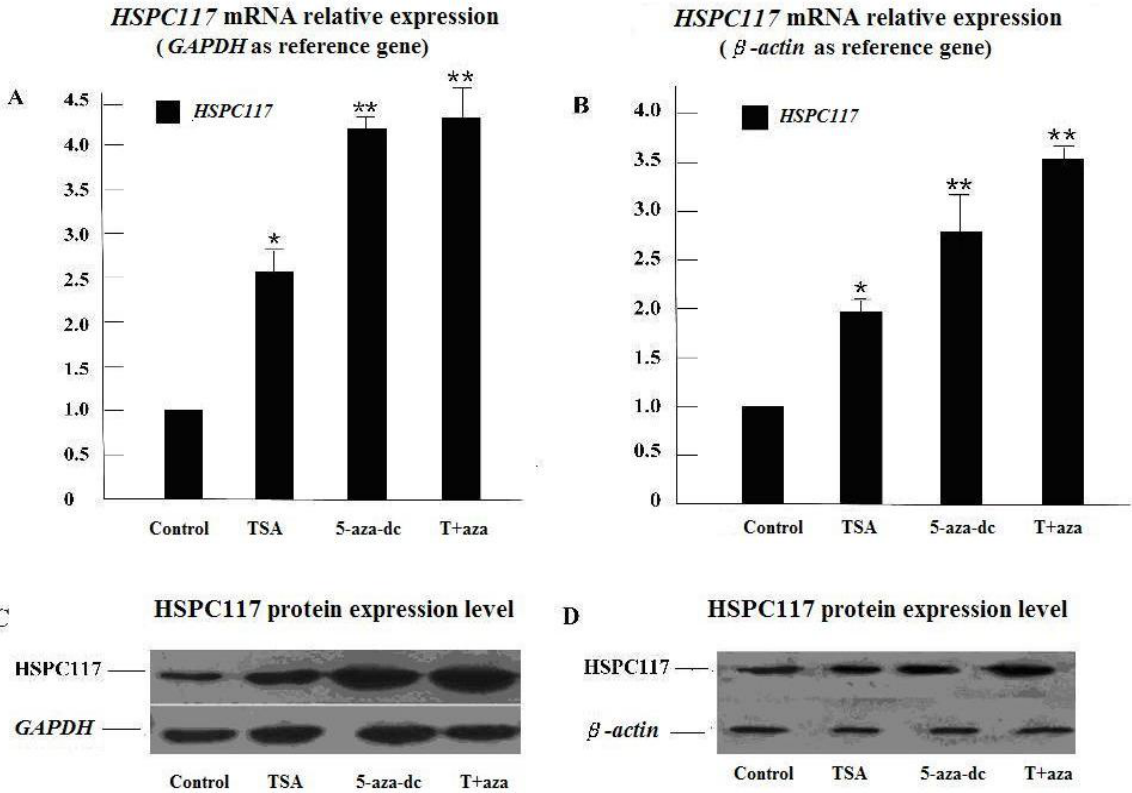
Figure 1. HSPC117 expressions in JEG-3 cells treated with TSA, 5-aza-dC or T + aza. ( A ) HSPC117 mRNA expression ( GAPDH as reference gene); ( B ) HSPC117 mRNA expression ( β-actin as reference). Each bar represents the mean of three independent experiments. ( * p < 0.05, ** p < 0.01, compared to control, respectively); ( C ) HSPC117 protein expression detected by Western blot analysis. The GAPDH protein was used as a control; ( D ) HSPC117 protein expression deleted by Western blot analysis. The β-actin protein was used as a